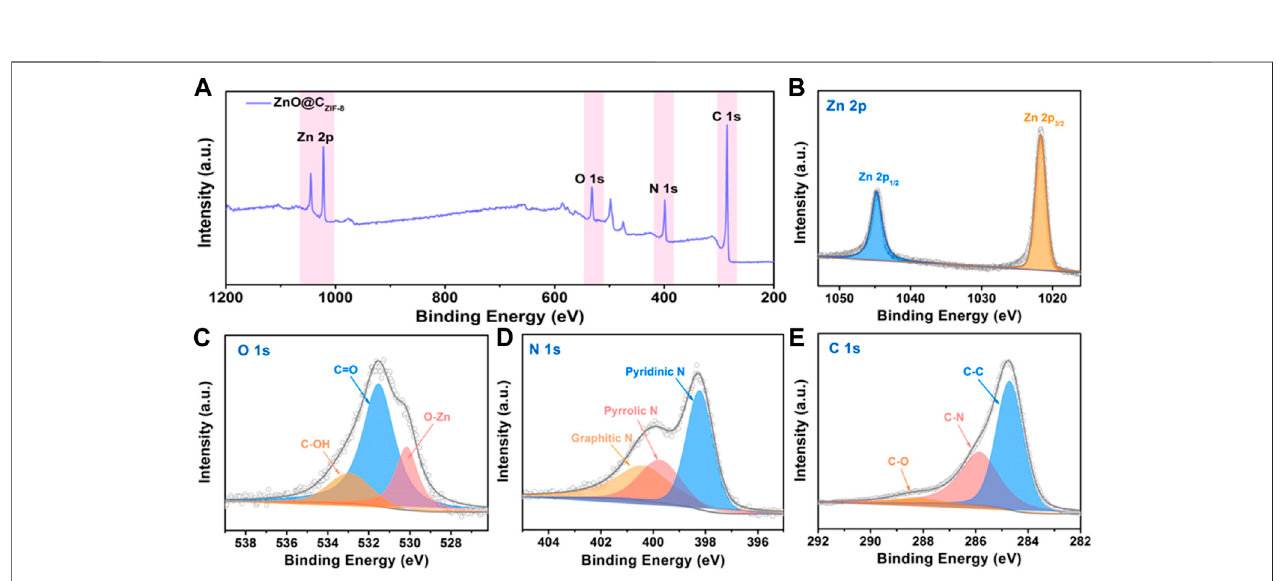
FIGURE 4 | (A) The Survey XPS spectrum of ZnO@C ZIF-8 microsphere. (B – E) High-resolution XPS spectra of Zn 2p, C 1s, O 1s, and N 1s.